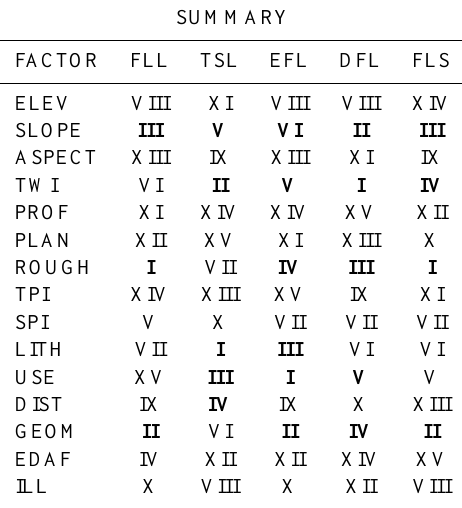
Table 3. Summary of classification of the determining factors for each type of slope failure. FLL: falls; TSL: Translation slides; EFL: Earth flows; DFL: Debris flows; FSL: Flow slides.